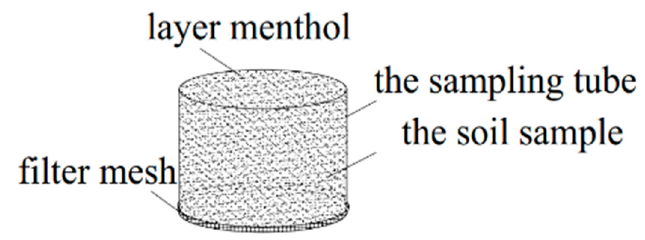
Figure 6. The sampling device of SEM.